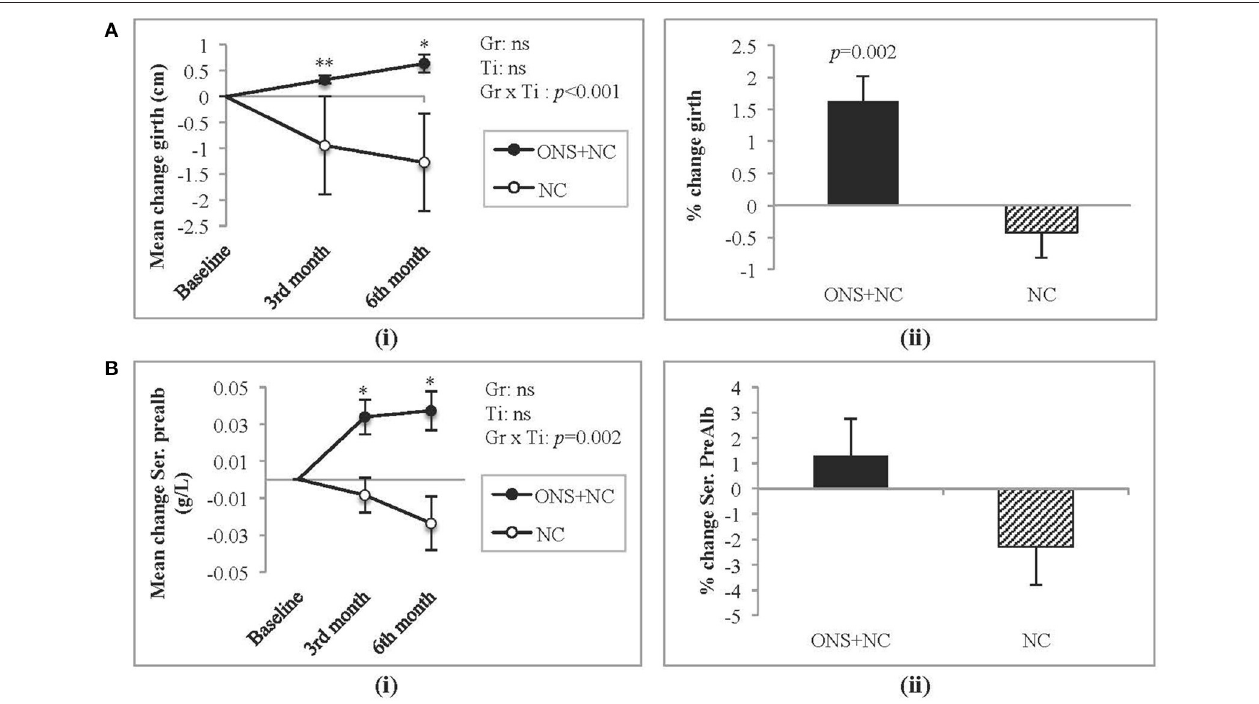
FIGURE 4 | Changes in mid-thigh girth and serum prealbumin levels. (A) Represents (i) mean change and (ii) percentage change in mid-thigh girth, whereas (B) represents (i) mean change and (ii) percentage change in serum prealbumin. Gr, main effect of Group; Ti, main effect of Time; Gr × Ti, Group × Time interaction; * p < 0.05; ** p < 0.001; Data were adjusted for age, gender, dialysis vintage, and presence of diabetes mellitus. NC, nutrition counseling; ns, not significant; ONS, oral nutritional supplementation; Prealb, prealbumin.